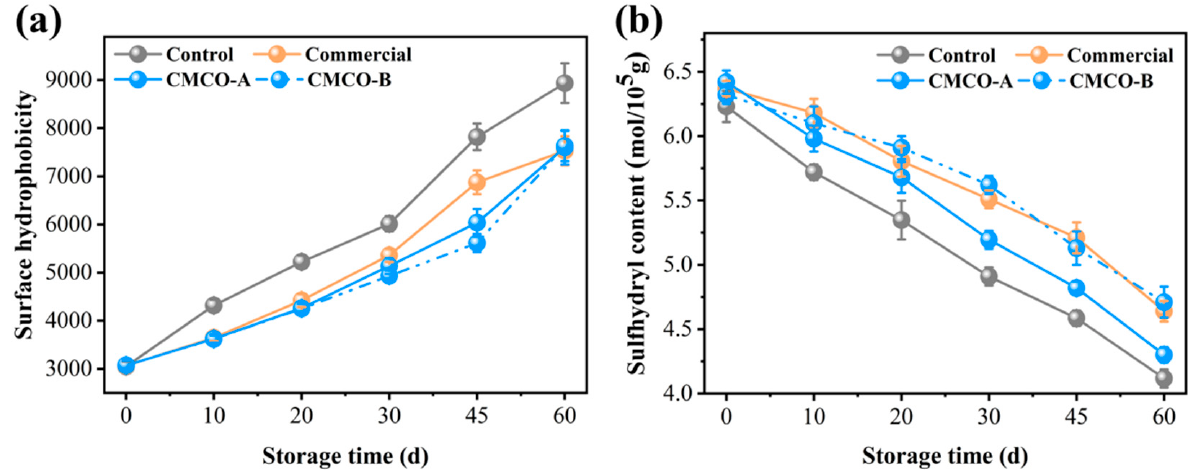
Figure 2. Effects of CMCO on surface hydrophobicity ( a ) and sulfhydryl content ( b ) of MP at different storage time.